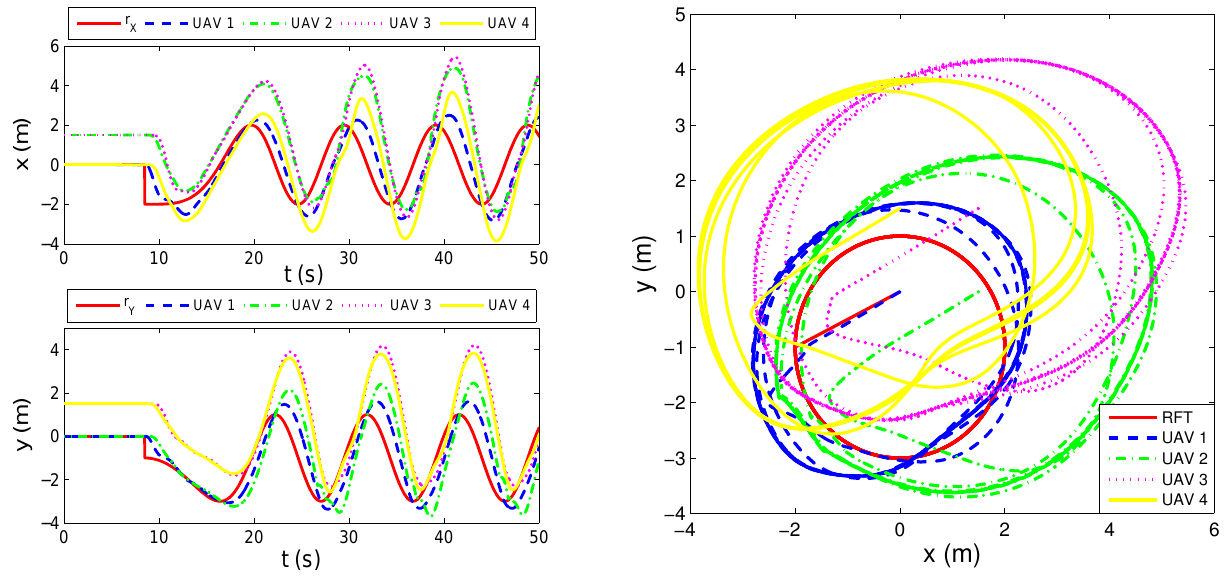
Figure 5. Formation control without high-order